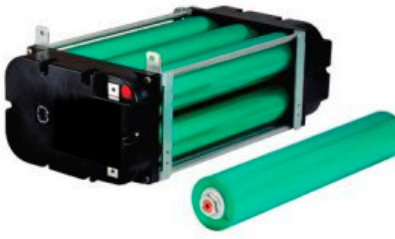
Figure 4. Test module of Li/Mn.